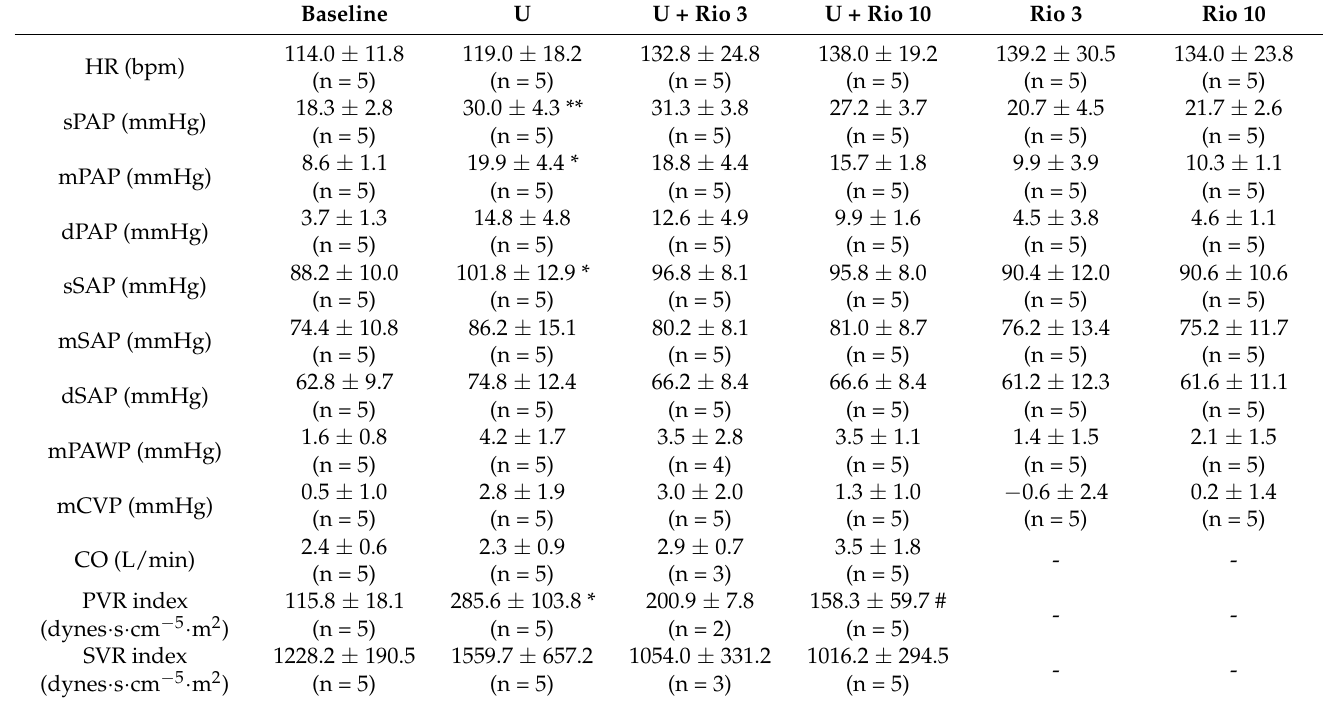
Table 1. Effects of riociguat on the hemodynamics of dogs with U46619-induced pulmonary hyper- tension. CO: cardiac output; CVP: central venous pressure; d: diastolic; HR: heart rate; m: mean; PAP: pulmonary arterial pressure; PAWP: pulmonary arterial wedge pressure; PVR: pulmonary vascular resistance; Rio 3: riociguat infusion of 3 µ g/kg per minute; Rio 10: riociguat infusion of 10 µ g/kg per minute; SAP: systemic arterial pressure; SVR: systemic vascular resistance; s: systolic; U: U46619 alone; U + Rio 3: U46619 + riociguat infusion of 3 µ g/kg per minute; U + Rio 10: U46619 + riociguat infusion of 10 µ g/kg per minute. The data are shown as mean ± SD. * p < 0.05 vs. baseline, ** p < 0.01 vs. baseline, # p < 0.05 vs.